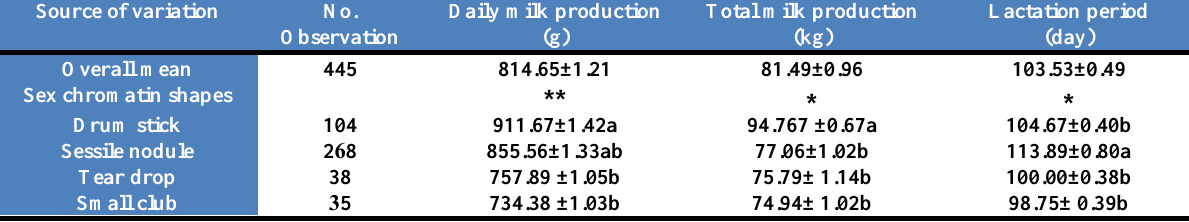
Table, 2: Effect of Sex chromatin shapes in milk production.